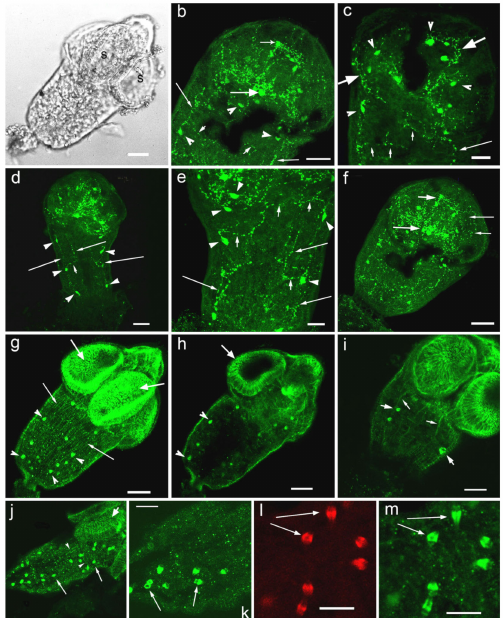
Figure 3. Immunoreactivity to serotonin ( b – f ) and 5-HT 7 serotonin receptor ( g – l ) in cysticercoid larvae of Hymenolepis diminuta. ( a )—cysticercoid of H. diminuta with suckers (s) in the scolex, transmission light microscopy, whole mount; ( b )—5-HT-IR in the scolex of H. diminuta , the lateral ganglia (thick arrow) and the rostellar ganglia (short arrow), the serotonergic neurons (arrowheads), the ventral nerve cords (thin long arrows) and transversal commissures between them (thin short arrows), the serotonergic nerve fibres (the rostellar nerves) extending from the lateral to the rostellar ganglia are visible; ( c )—5-HT-IR in the longitudinal nerve cords (long thin arrow), in commissures between them (short arrows), in the nerve cells along the nerve cords (arrowheads), in the nerve plexus and initial part of the longitudinal nerve cords (short thick arrows); ( d )—several pairs of 5-HT- IR neurons (arrowheads) situated along the major nerve cords (long thin arrows), the lateral ganglia are visible; ( e )—5-HT-IR in the longitudinal nerve cords (thin long arrows) and in the commissures between them (short arrows), in the nerve cells along nervous cords (arrowheads); ( f )—5-HT-IR in the lateral ganglion (long thick arrow), in the rostellar ganglion (short thick arrow), in the nerve fibres of the plexus within suckers (thin arrows); ( g )—5-HT 7 -IR along the longitudinal and transversal muscle fibers comprising the worm body wall (thin long arrows) and in the muscles of suckers (thick arrows), 5-HT 7 -IR is visible in the oval structures, probably the flame cells of the excretory system (arrowheads); ( h )—5-HT 7 -IR along the radial the muscle of the suckers (short arrow) and in the oval structures, the flame cells of the excretory system (arrowheads); ( i )—5-HT 7 -IR in the longitudinal muscle fibres of body (thin arrows), the 5 HT 7 -IR is visible in the oval structures (short thick arrows), the flame cells of the excretory system; ( j )—5-HT 7 -IR in the longitudinal and transversal (arrowheads) muscle fibres of the body and in the muscles of the sucker (short thick arrow), 5-HTR 7 -IR is also present in the oval structures, the flame cells of the excretory system (long arrows); ( k )—5-HT 7 -IR in the oval structures (long arrows), the flame cells, scattered in the cysticercoid body; ( l )—phalloidin staining of the oval structures having positive 5-HT 7 -IR, the larger magnification; ( m )—5-HT 7 -IR in the oval structures (long arrows), presumably, the flame cells of the excretory system, the large magnification. Scale bars: ( a , b , d , f , g – j )—20 µ m; ( c , e , k – m )—10 µ